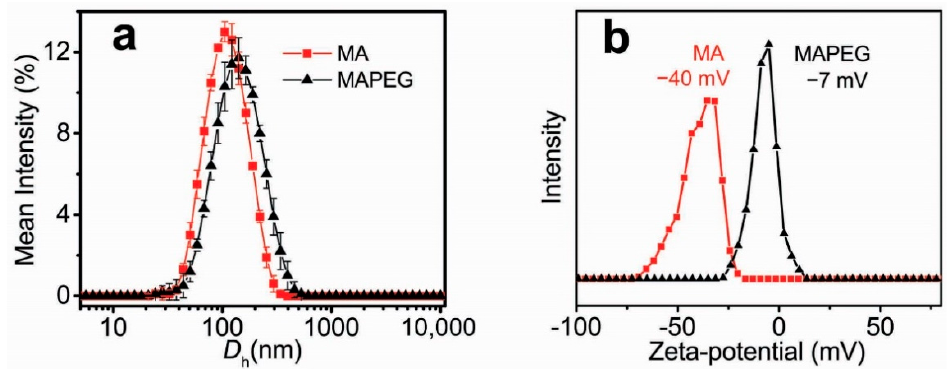
Figure 1. ( a ) Hydrodynamic diameters ( D h ’s) and ( b ) ζ -potentials of the plain (MA) and PEGylated (MAPEG) co-CNCs MIONs.